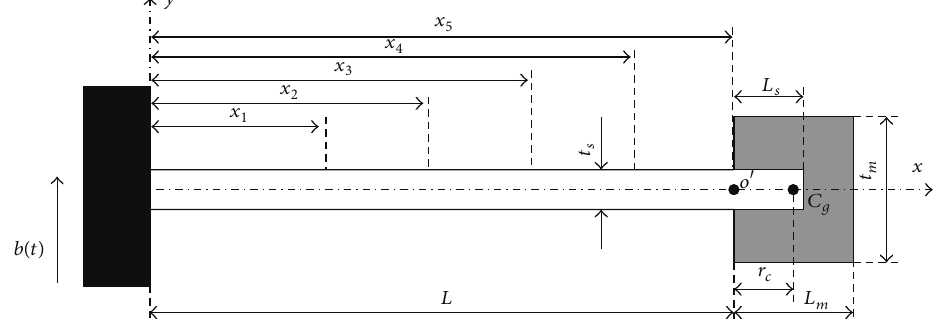
Figure 9: Typical cantilever beam with a tip-mass.